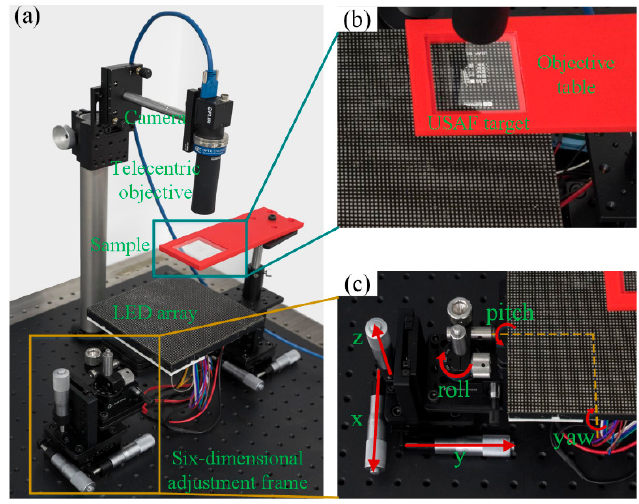
Figure 2. The implemented FPM platform. ( a ) The framework and basic components. ( b , c ) Enlargement details of the subregions in ( a ).